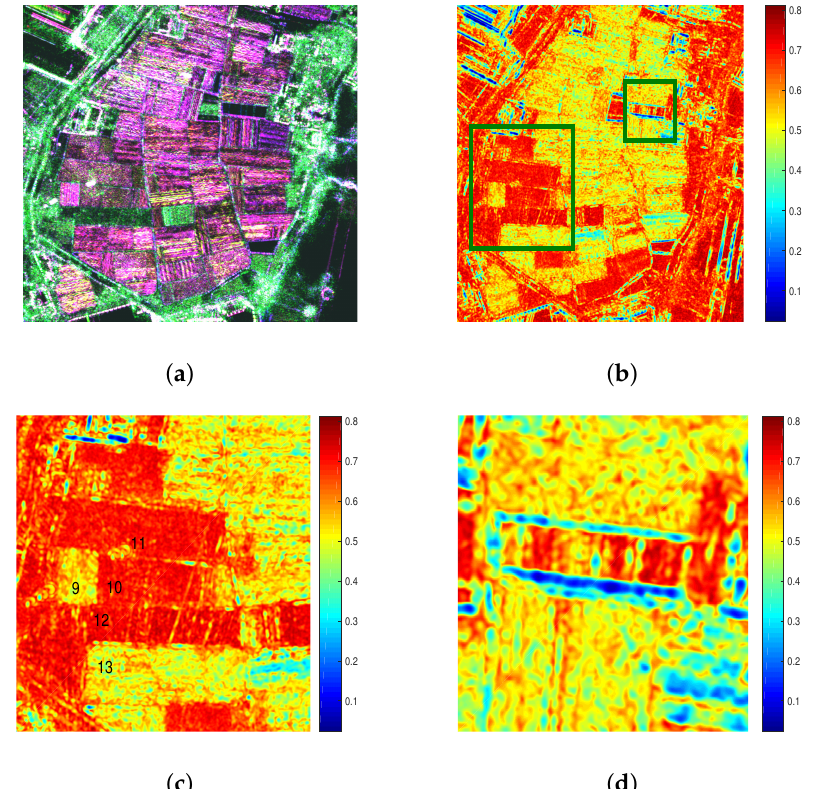
Figure 9. Farmland: ( a ) Original image using Pauli basis (blue: | H + V | ; red: | H − V | ; green: 2 | HV | ); ( b ) MAPE; ( c ) enlarged image of five targets; and ( d ) enlarged image of farmland with Bragg